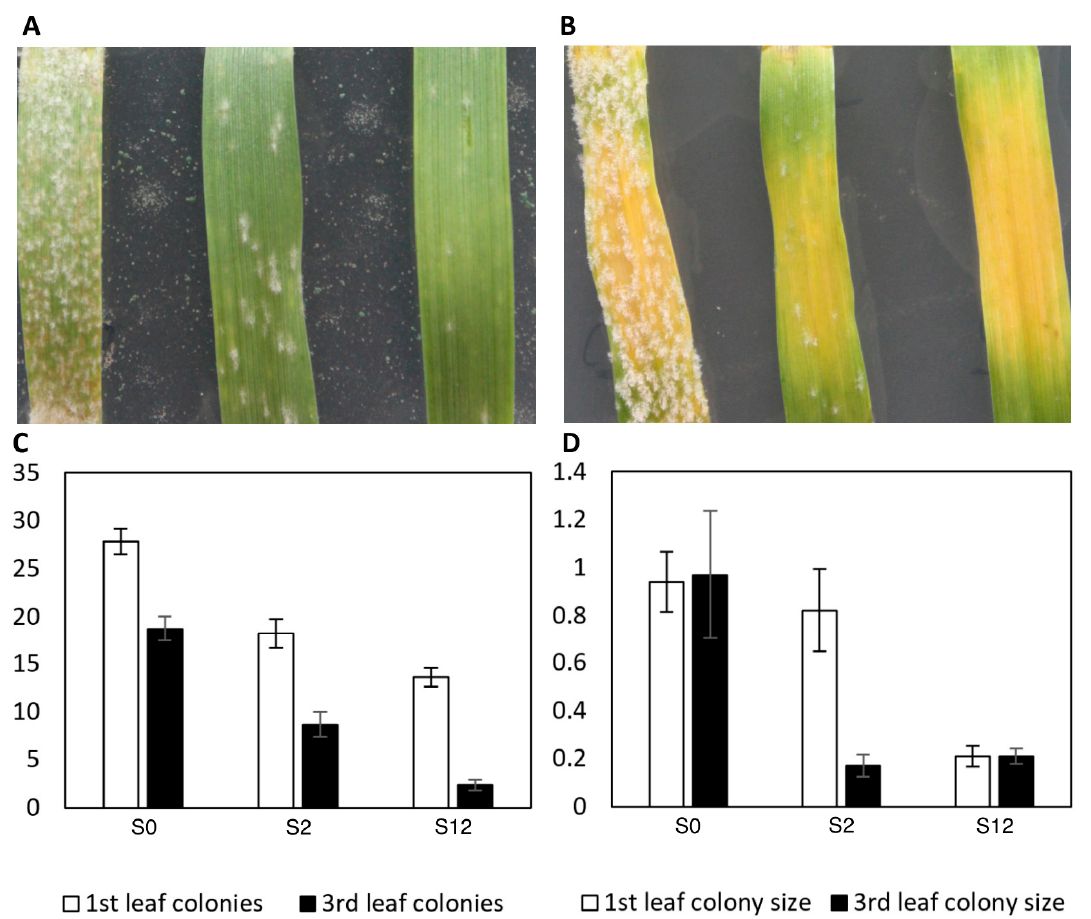
Figure 2. Colony number and size di ff erences in detached leaf assays for the first ( A ) and third leaves ( B ) with isolate Chi-001. Leaves are ordered from left to right by S0 ( Mlo wild-type control), S2 ( mlo-11 ( cnv2 ), and S12 ( mlo-11 ), respectively. Colony counts per cm 2 and sizes in mm are shown in ( C ) and ( D ), respectively, according to five detached leaf replicates per growth stage. Figure 2C shows colony number ( y -axis) di ff erences between first and third leaves. Figure 2D similarly shows colony size ( y -axis) di ff erences between first and third leaves. Error bars are standard errors for five replicates ( C ) and ( D ).